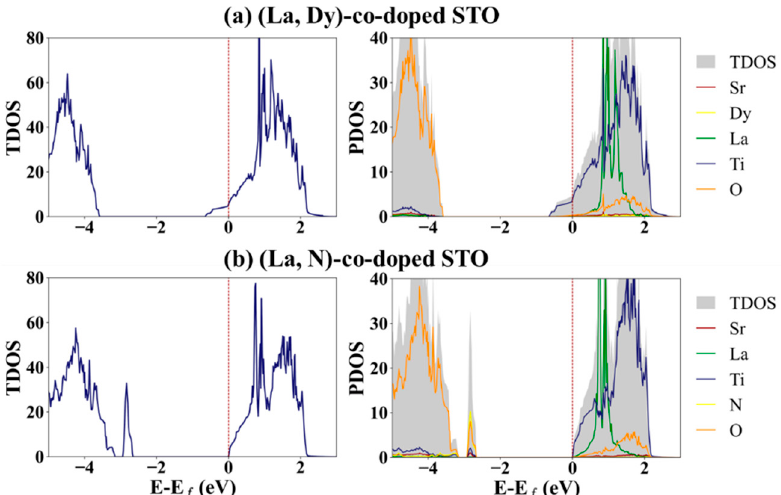
Figure 4. TDOS of ( left ) (La, Dy) co-doped SrTiO 3 and, ( right ) (La, N) co-doped SrTiO 3 with dashed lines denoting E f , located at 6.27 and 5.39 eV for (La, Dy) co-doped STO and (La, N) co-doped STO, respectively.